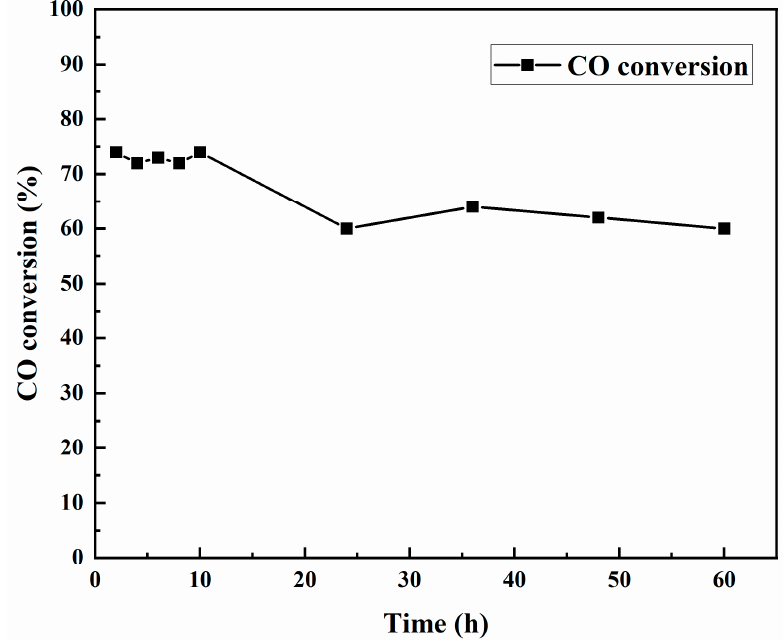
Figure 9. Fischer–Tropsch deactivation studies of cobalt catalyst deposited in silicon microchannel microreactor.